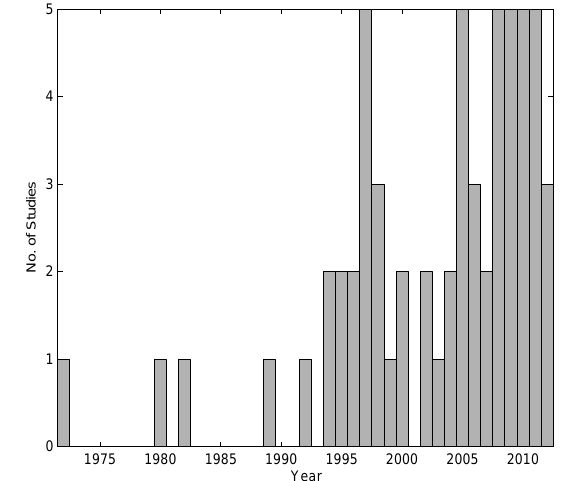
Fig. 4. Number of studies per year on lidar turbulence measure-